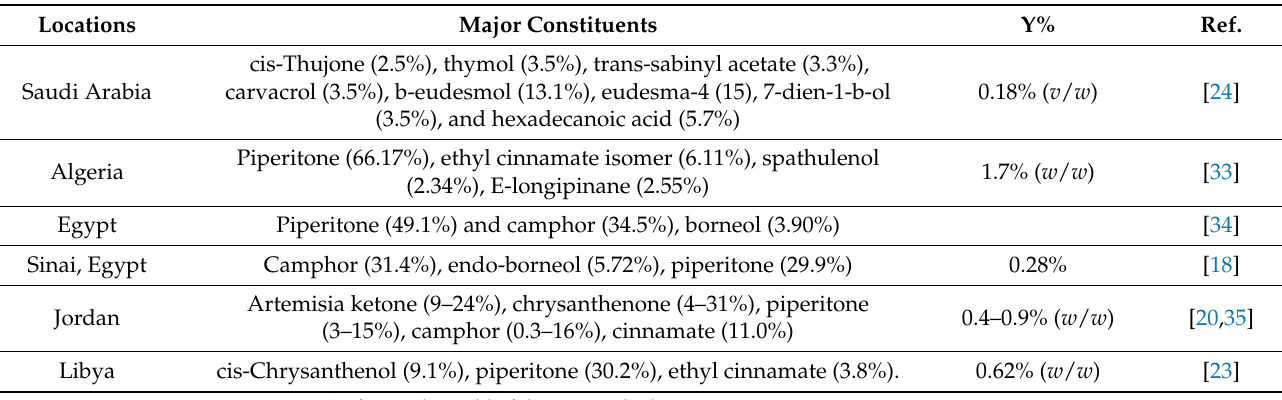
Table 1. Major constituents of the ArJ essential oils from plant species growing in different